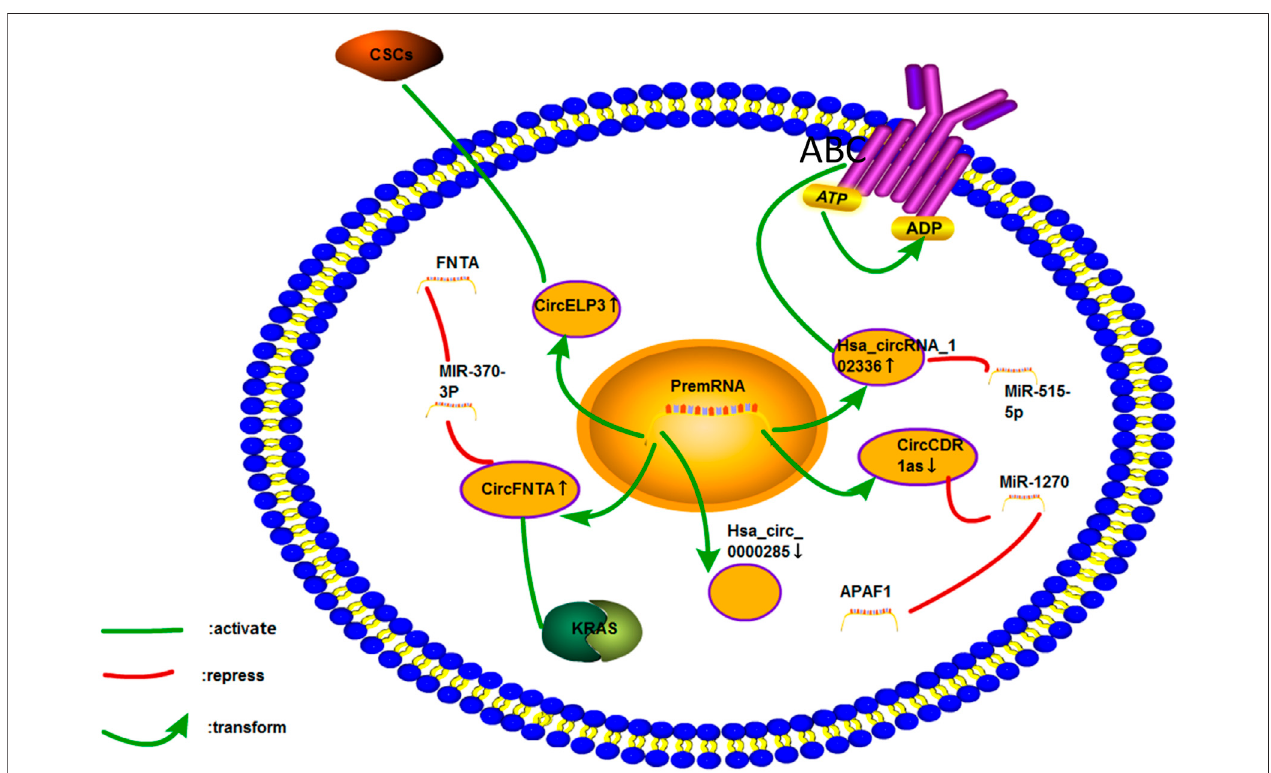
FIGURE11| CisplatinresistancemechanismofcircRNAinbladdercancer.Only fi vecircRNAsassociatedwiththecisplatinresistanceofbladdercancerhavebeen studied. The mechanisms involved include ceRNA NET, CSCs, ABC transporter, and KRAS pathways.